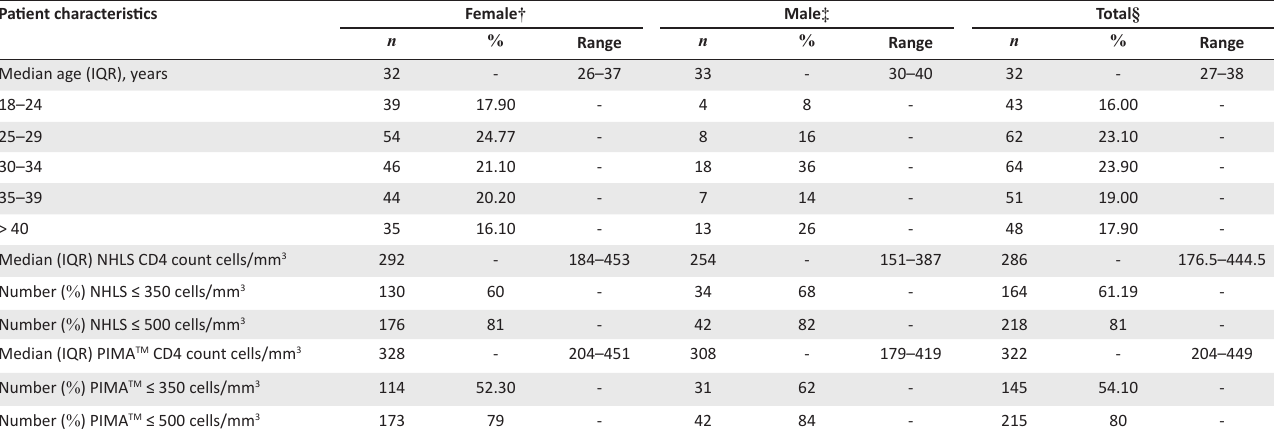
TABLE 1: Characteristics of HIV-1-positive individuals undergoing CD4+ T-cell count enumeration. Patient